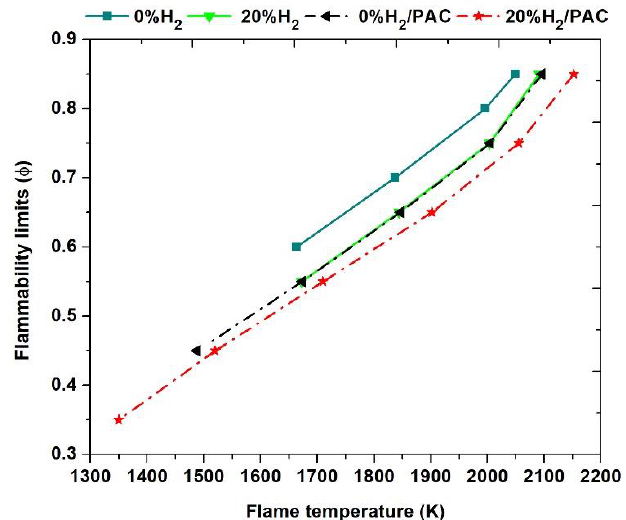
Figure 14. Flammability limits with different blends of hydrogen without or with NSPD.